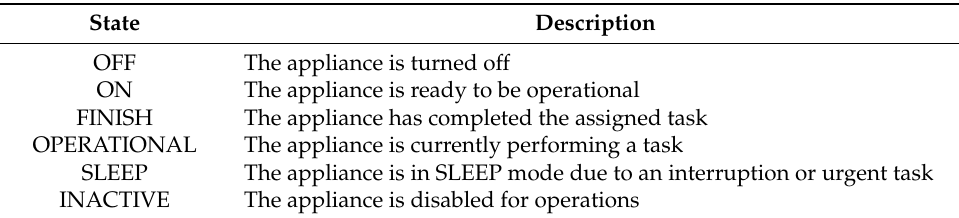
Table 1. Appliance states and